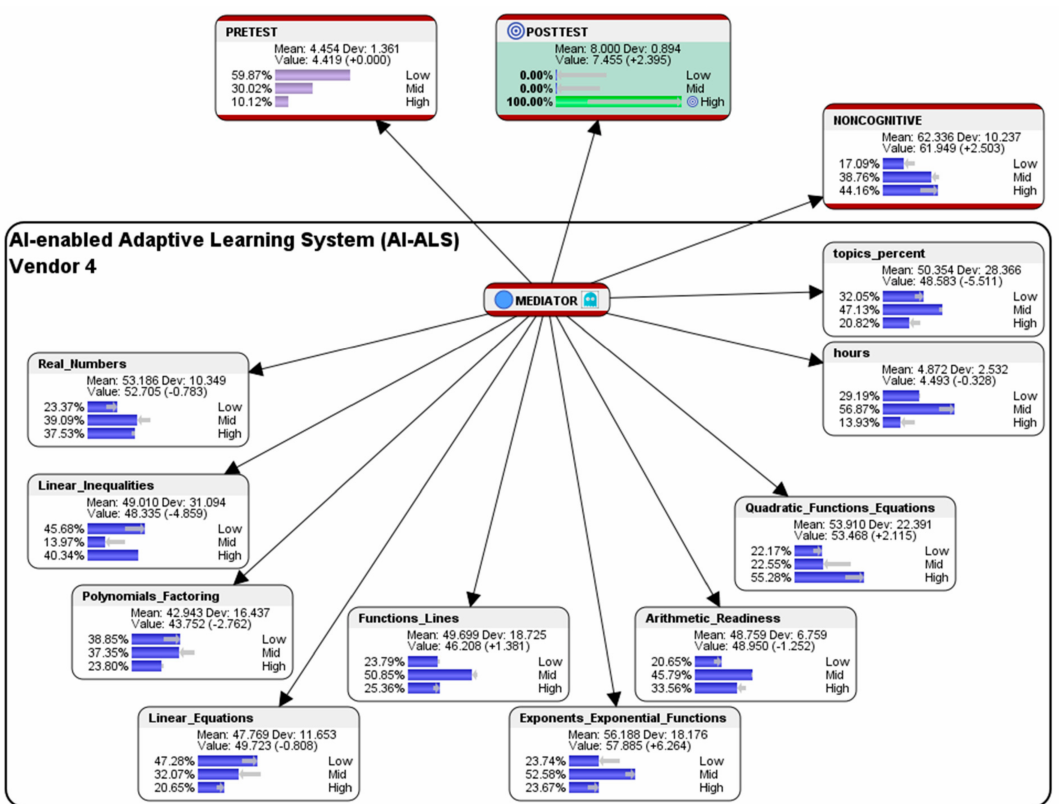
Figure 19. Simulation of counterfactual results for 100% of the students who had used Vendor 4 (cid:48) s AI-ALS to score at the high-level in the post-test. Grey arrows recommended whether there should be an increase (pointing to the right), or a decrease (pointing to the left) in each respective mathematics topic’s score-clusters for Low-, Mid-, and